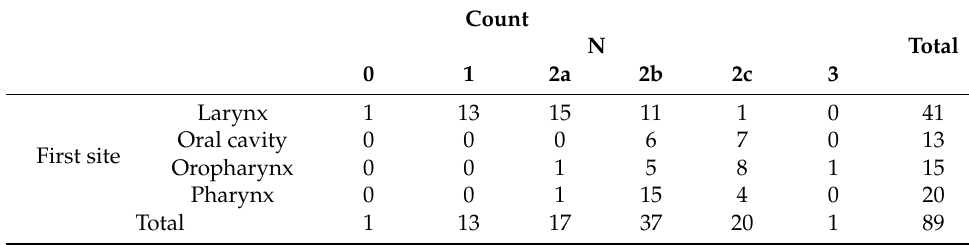
Table 3. Site of the primary tumour